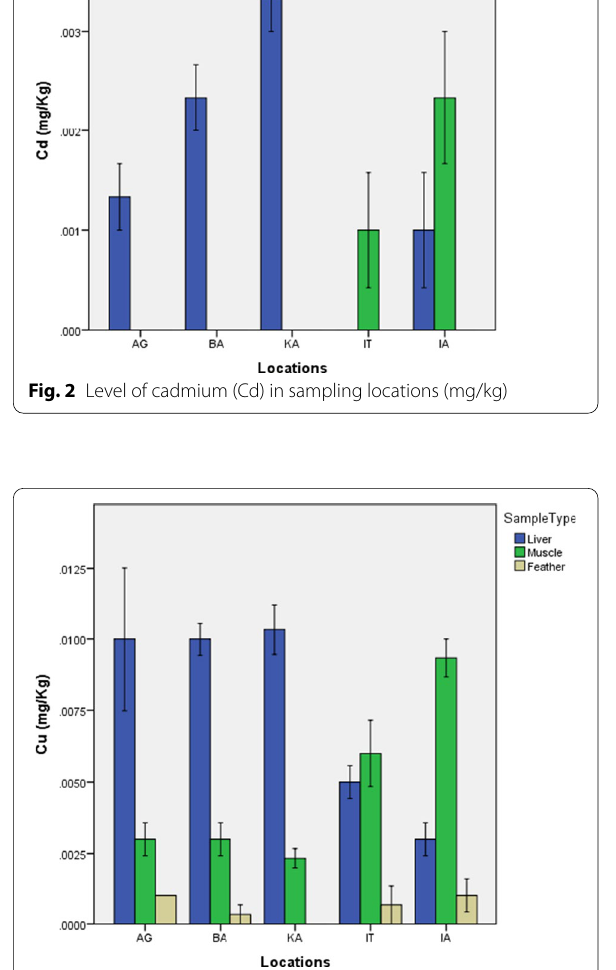
Fig. 5 Level of lead (Pb) in sampling locations